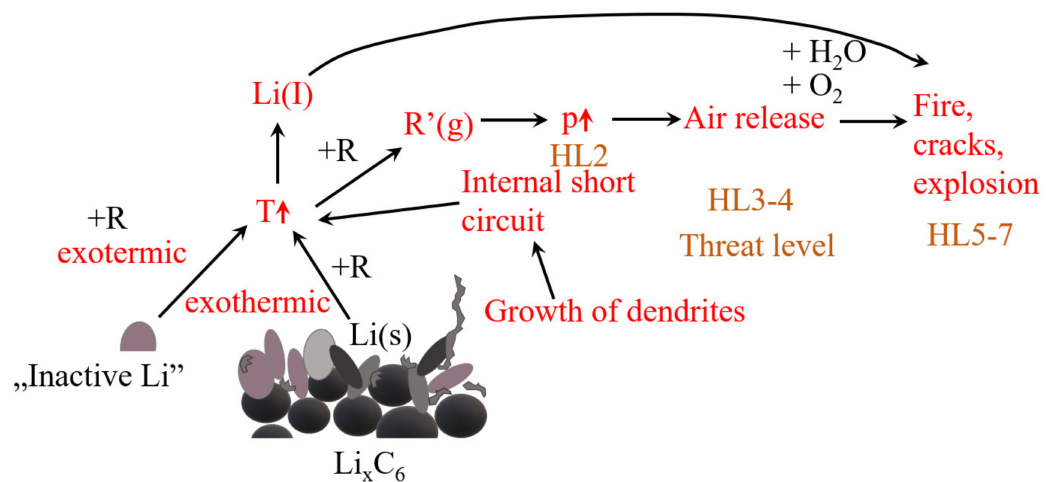
Figure 4. The effect of lithium deposition on the safety of LIBs, where HLs are the different hazard levels of degradation of 1 M LIPF 6 in EC:DMC.